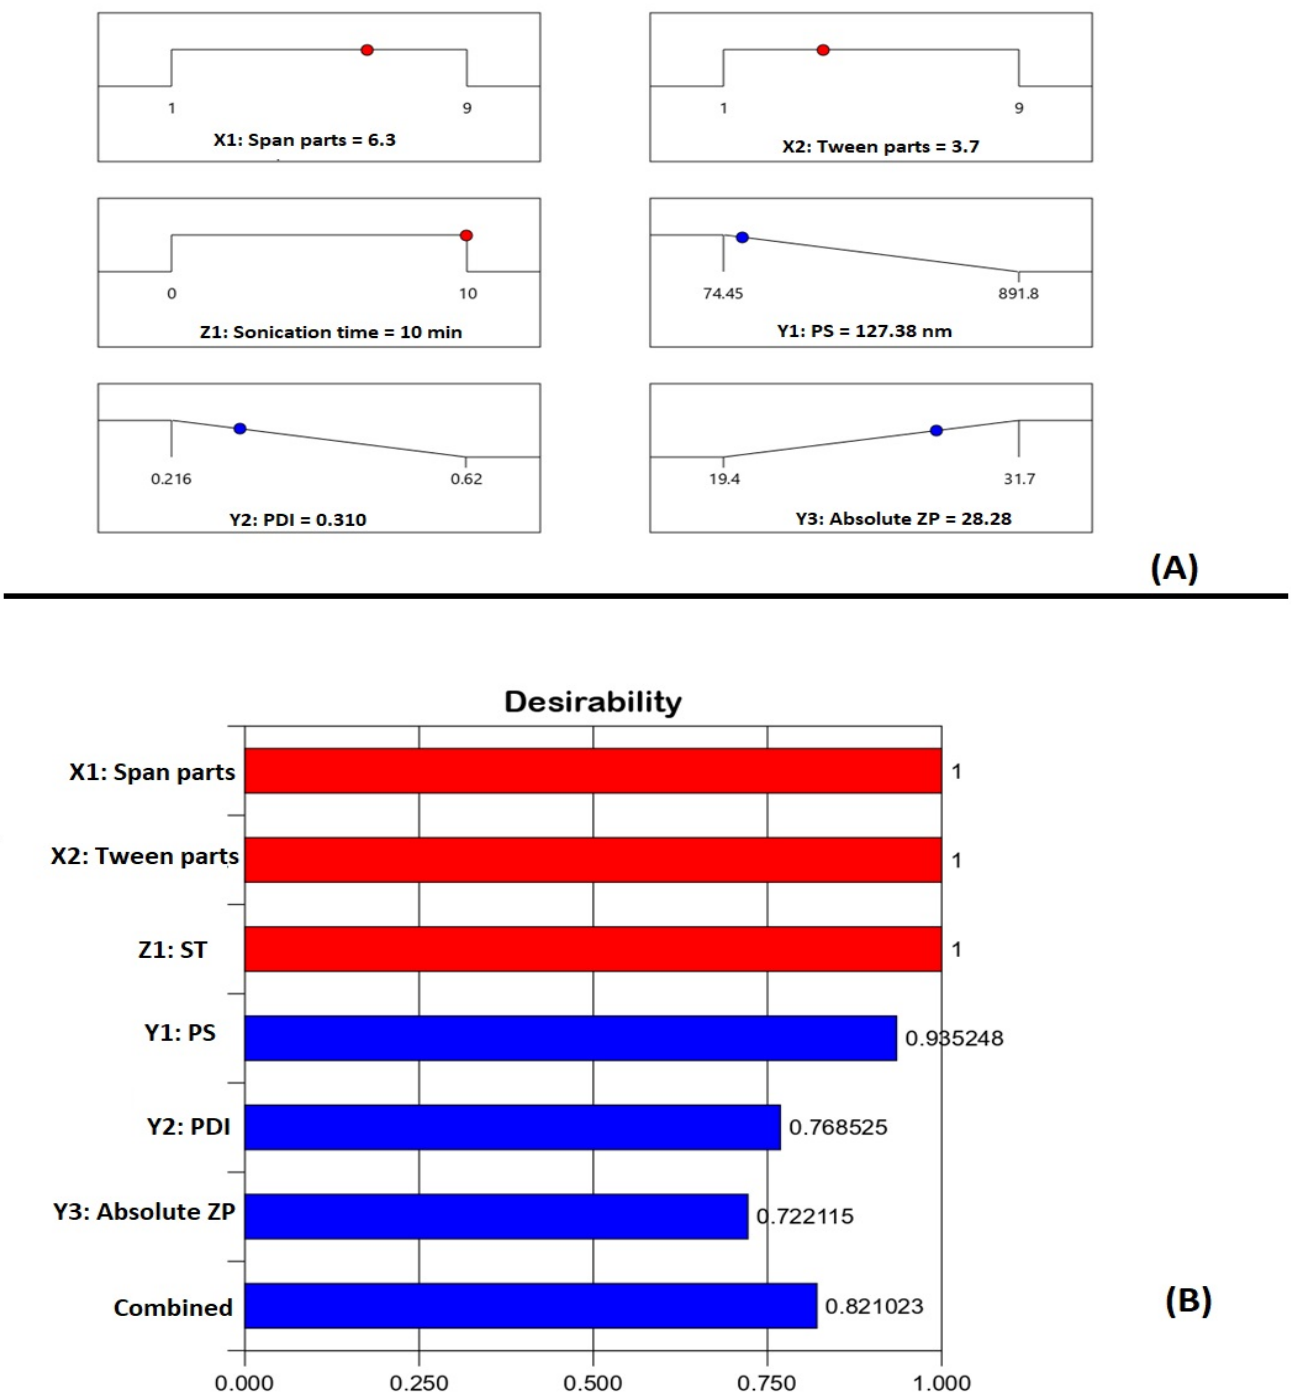
Figure 5. ( A ) Ramp graphs representing the optimized levels of Span 60, Tween 80, and sonication time, in addition to the predicted responses for the optimized SMV-SPNs. ( B ) Desirability values for the predicted responses and overall desirability of the optimized SMV-SPNs. Abbreviations: SMV, simvastatin; SPNs; spanlastics; ST, sonication time (min); PS, particle size; PDI, Polydispersity index; ZP, zeta potential.